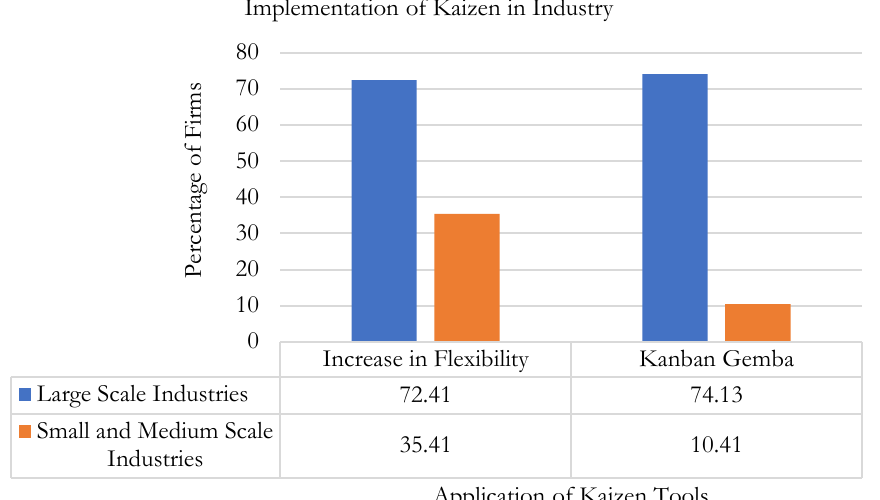
Fig. 5. Comparison of kaizen tools between two